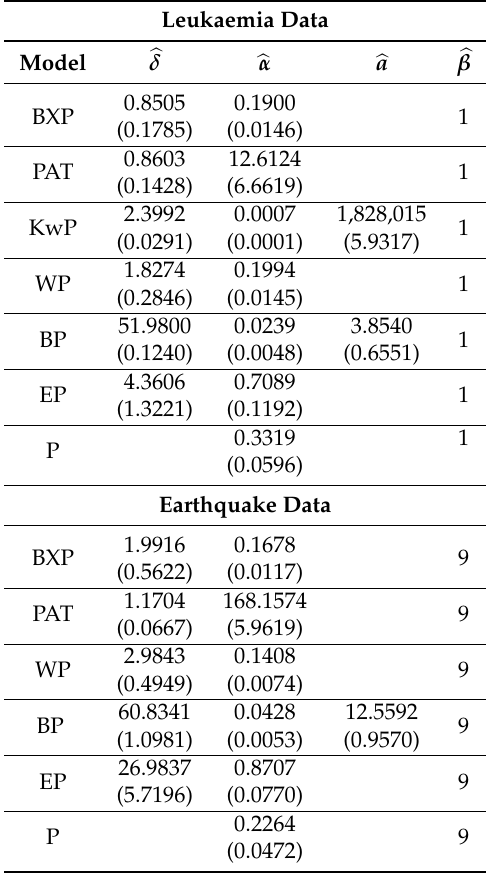
Table 3. MLEs and their standard errors (in parentheses) for both datasets. P, Pareto; PAT, P ArcTan;